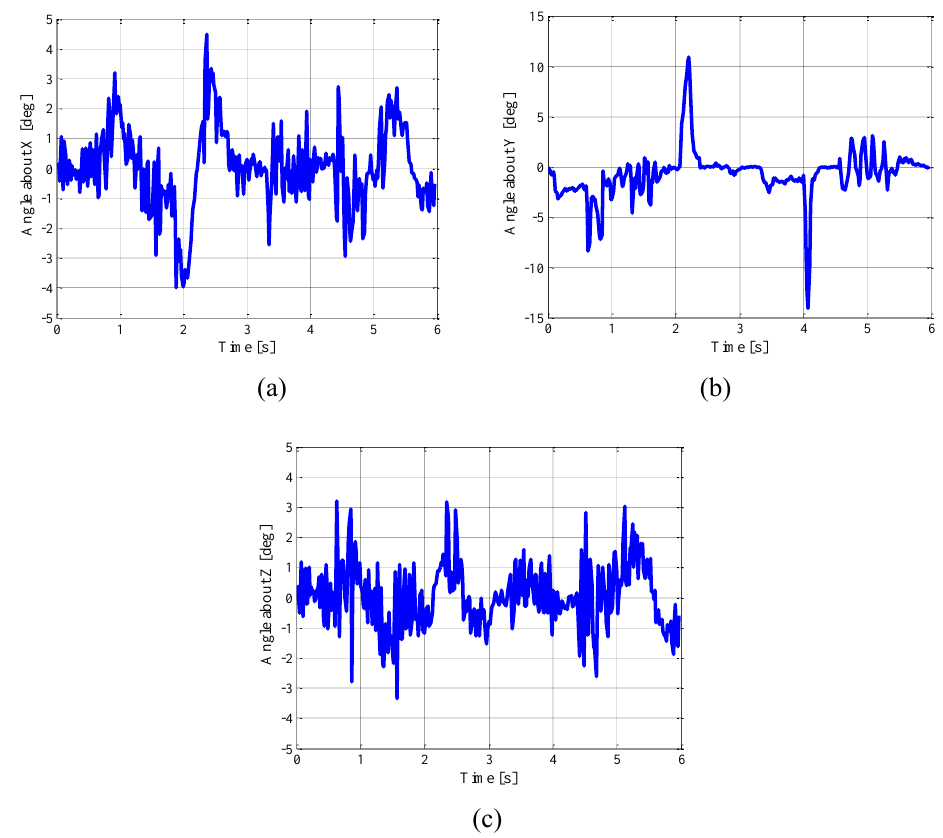
Figure 8. Measured rotation angles of the foot platform: (a) about x 2 axis; (b) about y 2 axis; (c) about z 2 axis.